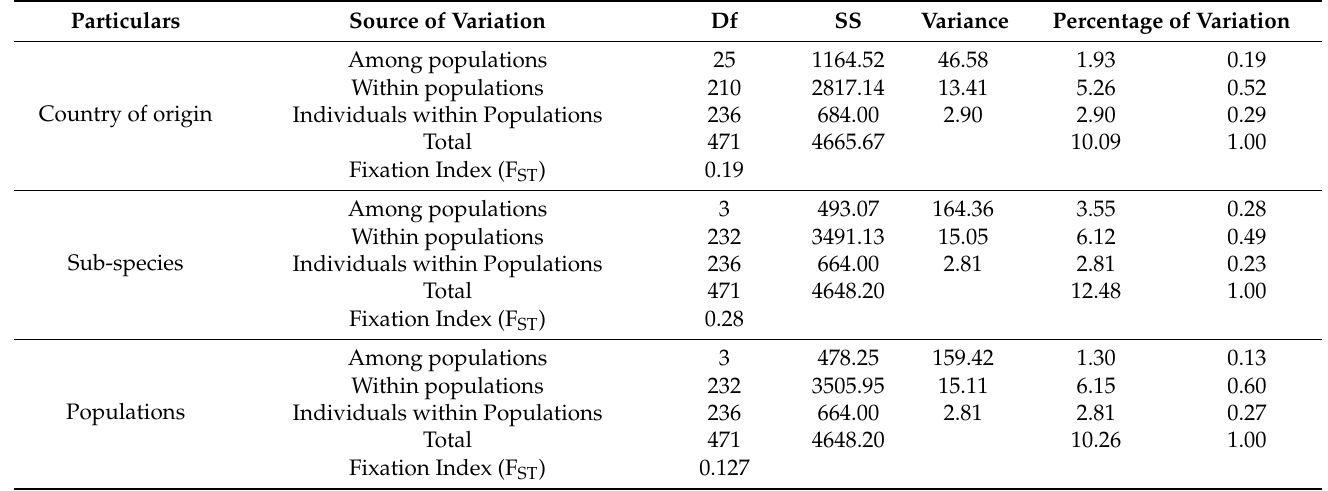
Table 6. Analysis of molecular variance (AMOVA) of 200 tropical japonica lines including checks based on three parameters, origin, subspecies, and